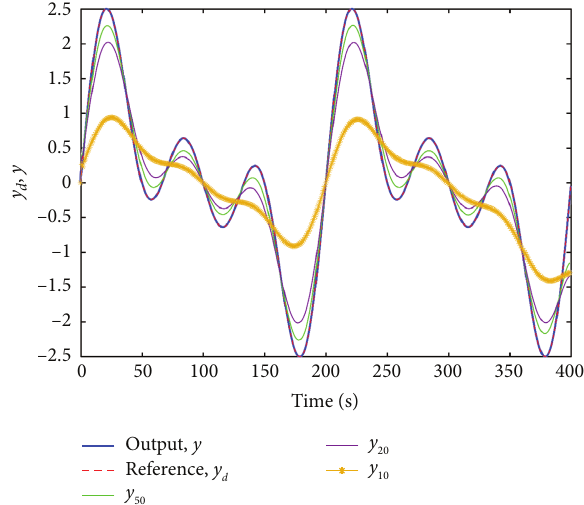
Figure 7: Output versus reference trajectory curve with actuator failure.